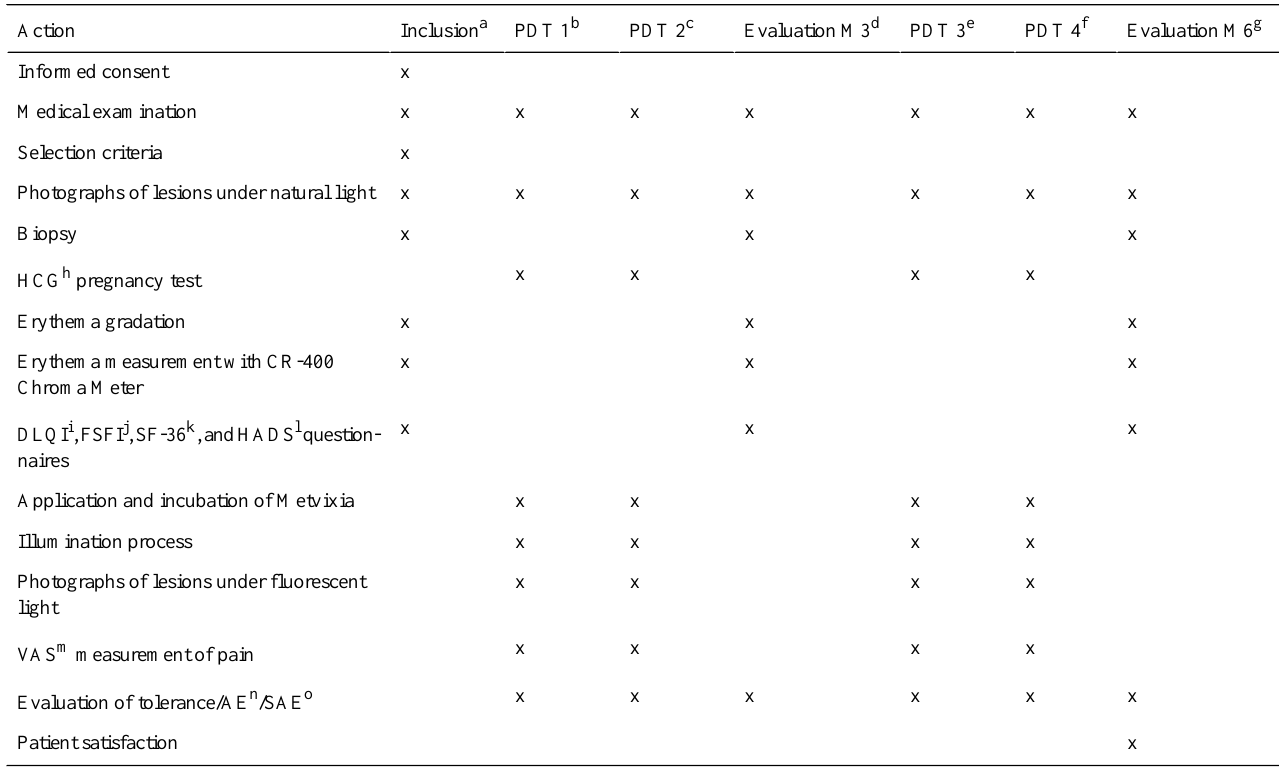
Table 2. Study procedures and